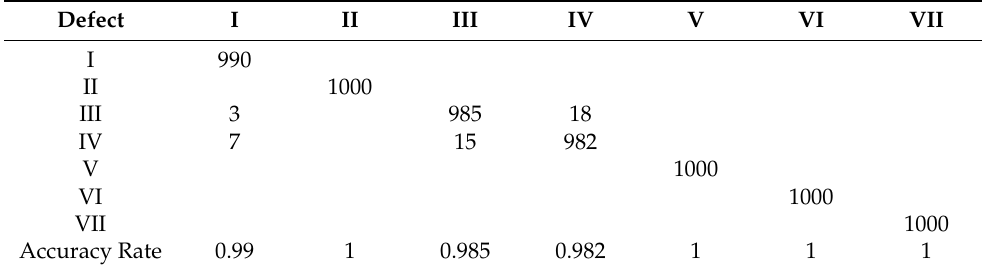
Table 4. Statistics of chip plastic surface defect image recognition results. I: no defect; II: edge